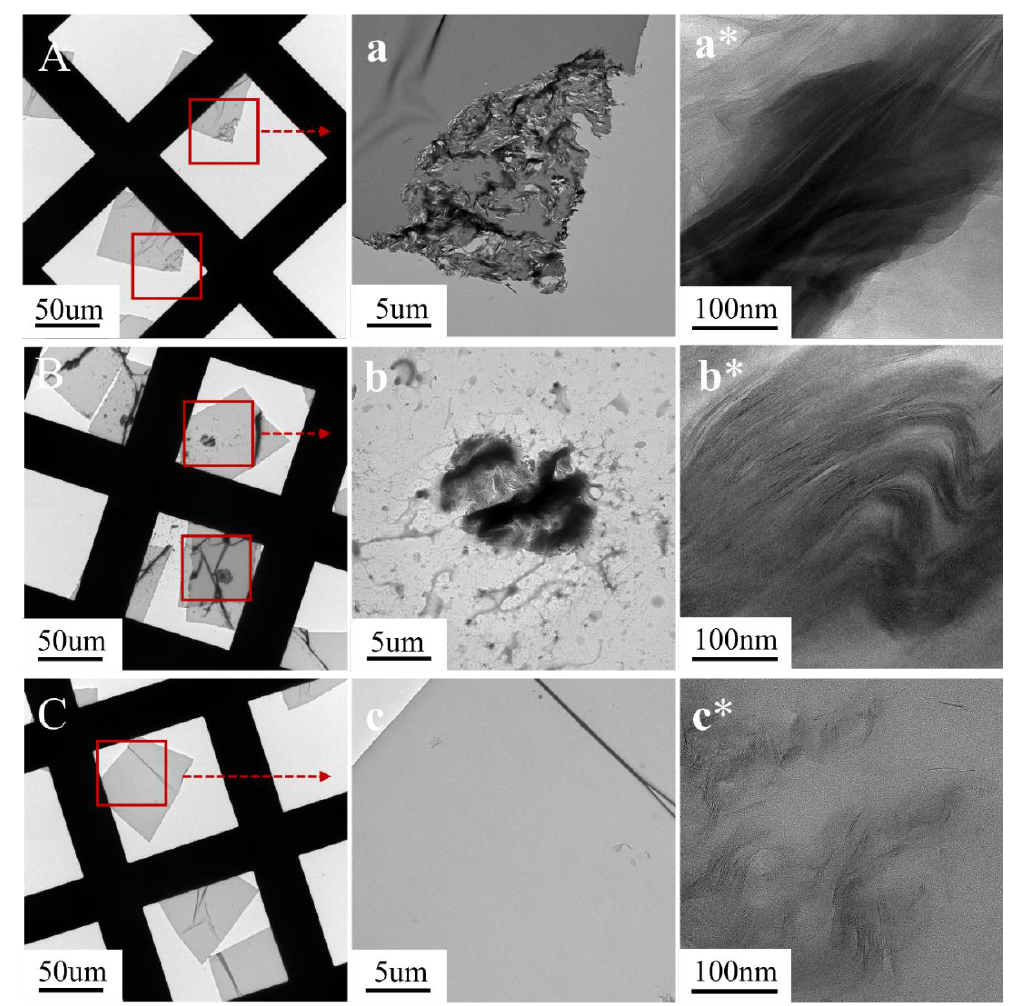
Figure 4. TEM image of EPs. ( A , a , a* ) EP/ MMT; ( B , b , b* ） ; EP/DOPO+MMT; ( C , c , c* ) EP/DOPO-MMT.